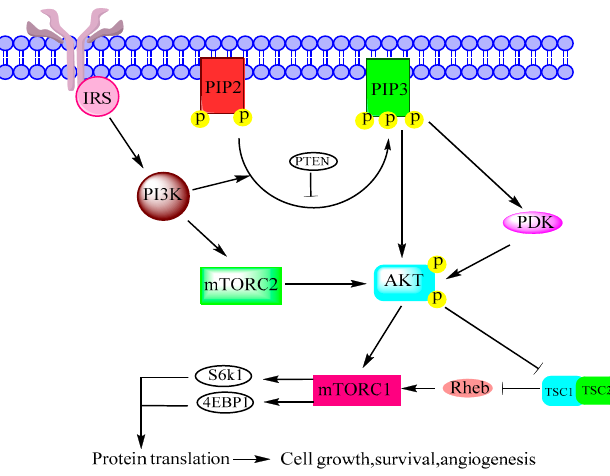
Figure 2. Phosphoinositide 3-kinase (PI3K)/protein kinase B (AKT)/mTOR pathway adapted from figure 2 of [6] and figure 1 of [16]. Insulin receptor substrate (IRS), phosphatase and tensin homolog (PTEN), phosphatidylinositol bisphosphate (PIP2), phosphatidylinositol trisphosphate (PIP3), tuberous sclerosis (TSC), Ras homolog enriched in brain (Rheb), S6 kinase beta-1 (S6K1).